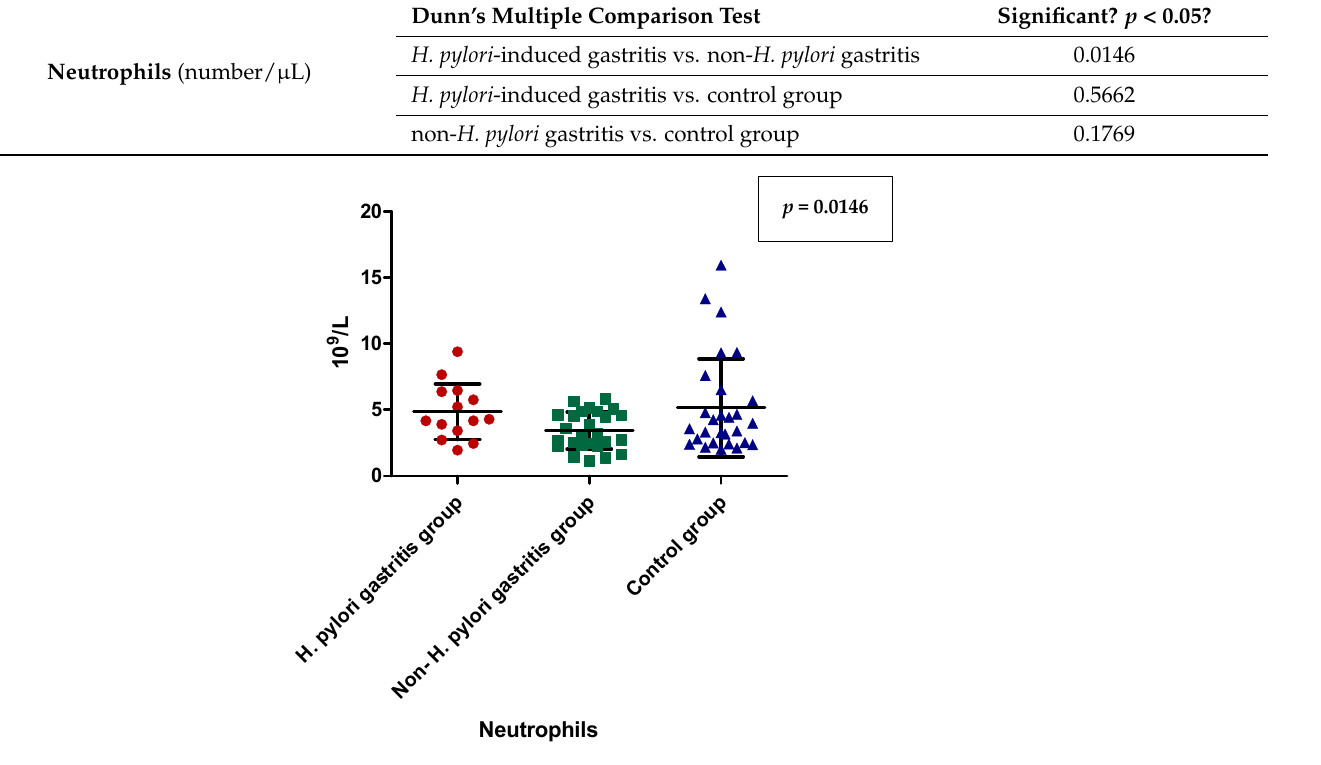
Figure 2. The difference of median values of MCHC between the three groups.